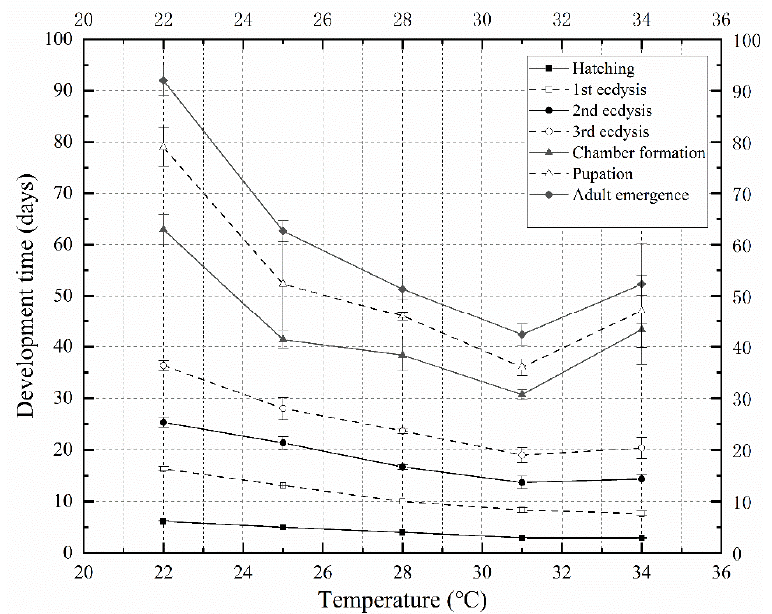
Figure 2. Isomorphen diagram of Necrobia ruficollis . The duration of each development event (hatching, 1st ecdysis, 2nd ecdysis, 3rd ecdysis, chamber formation, pupation, and adult emergence) is plotted against the time from oviposition to the onset of each event. Each curve corresponds to a particular development event. The error bar represents the